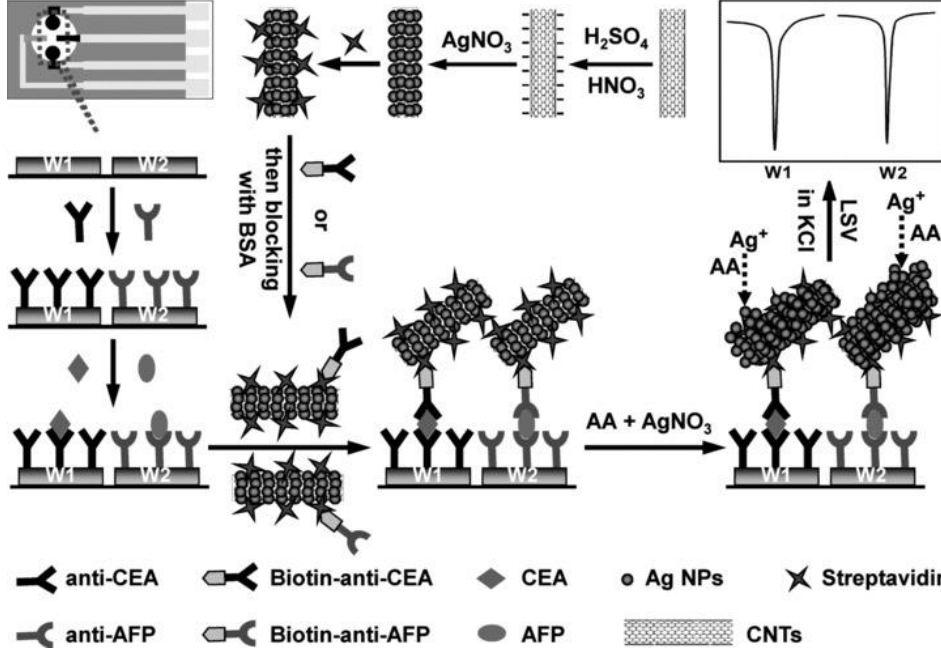
Figure 1. Schematic representation of preparation of immunosensor array and trace tag, and detection strategy by linear-sweep stripping voltammetric analysis of Ag NPs on the immunosensor surface. Reproduced with permission from [18], Wiley, 2011.